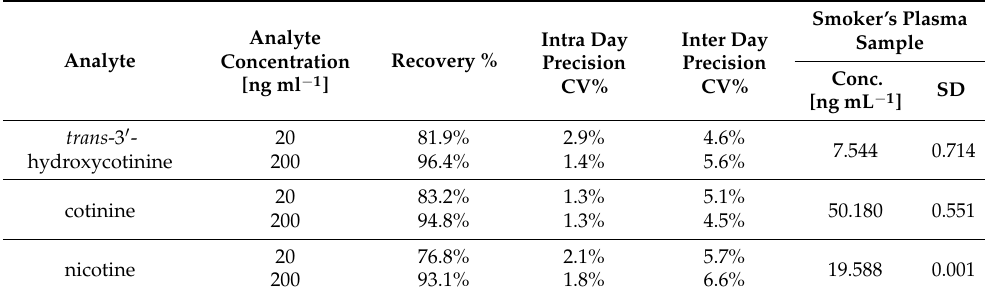
Table 5. Recovery and precision of the investigated analytes quantification evaluated by HPLC-QQQ- MS/MS. Analyte Intra Day Recovery % Analyte Concentration Precision [ng ml − 1 ] CV% trans -3 (cid:48) -